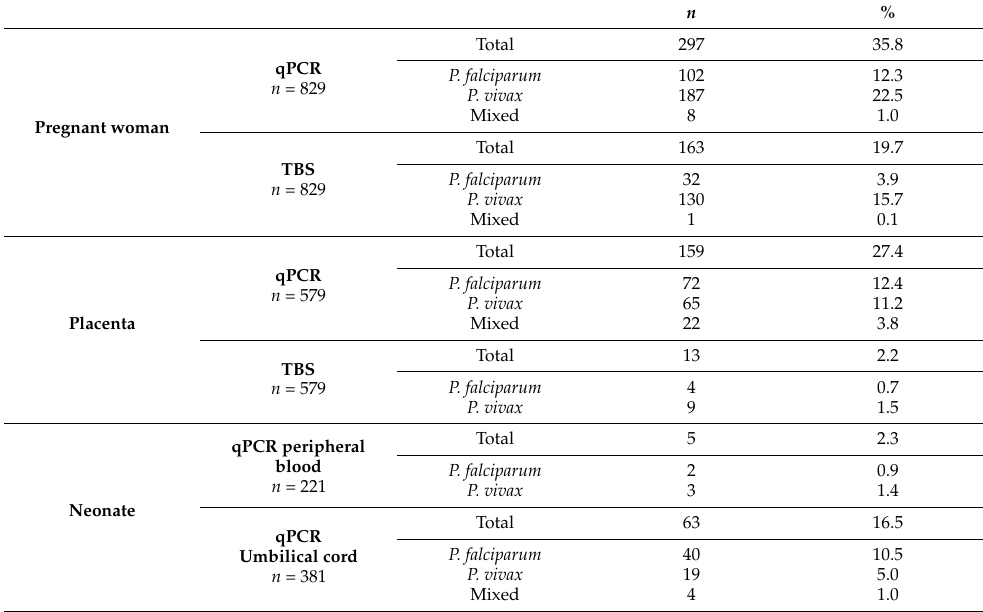
Table 1. Description of the study population according to the source (mother, placenta, or neonate) Plasmodium